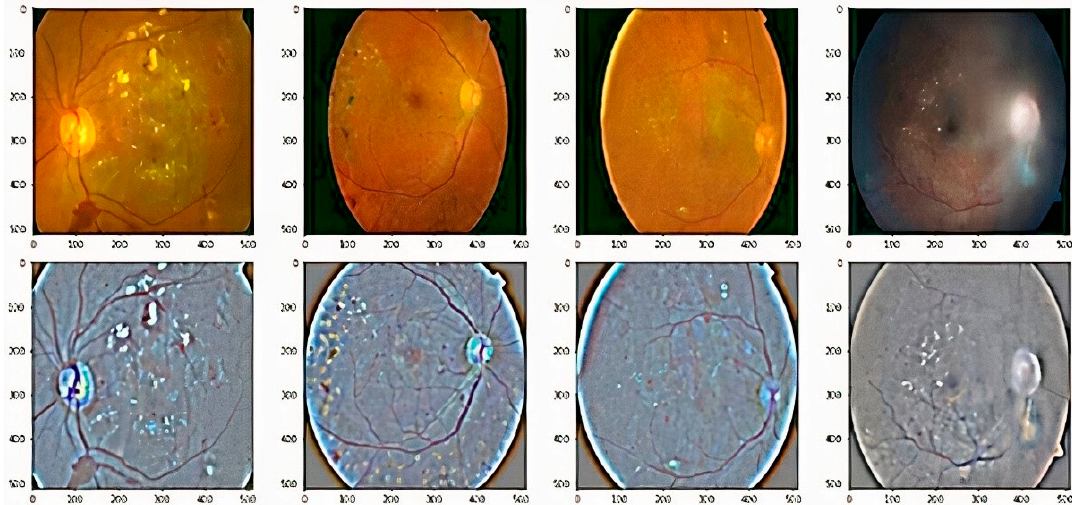
Figure 4. The preprocessed retinal images after applying contrast limited adaptive histogram equalization to adjust contrast in images. ( a , c ) Original retinal fundus images, ( b , d ) preprocessed images.